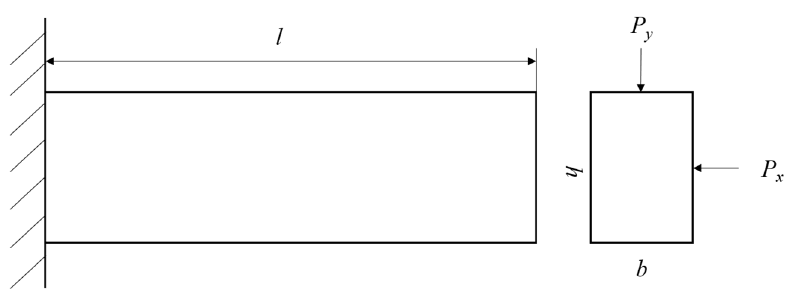
Figure 4. Configuration of the cantilever beam. Table 2. Descriptions of the input variables in Section 3.2.2.